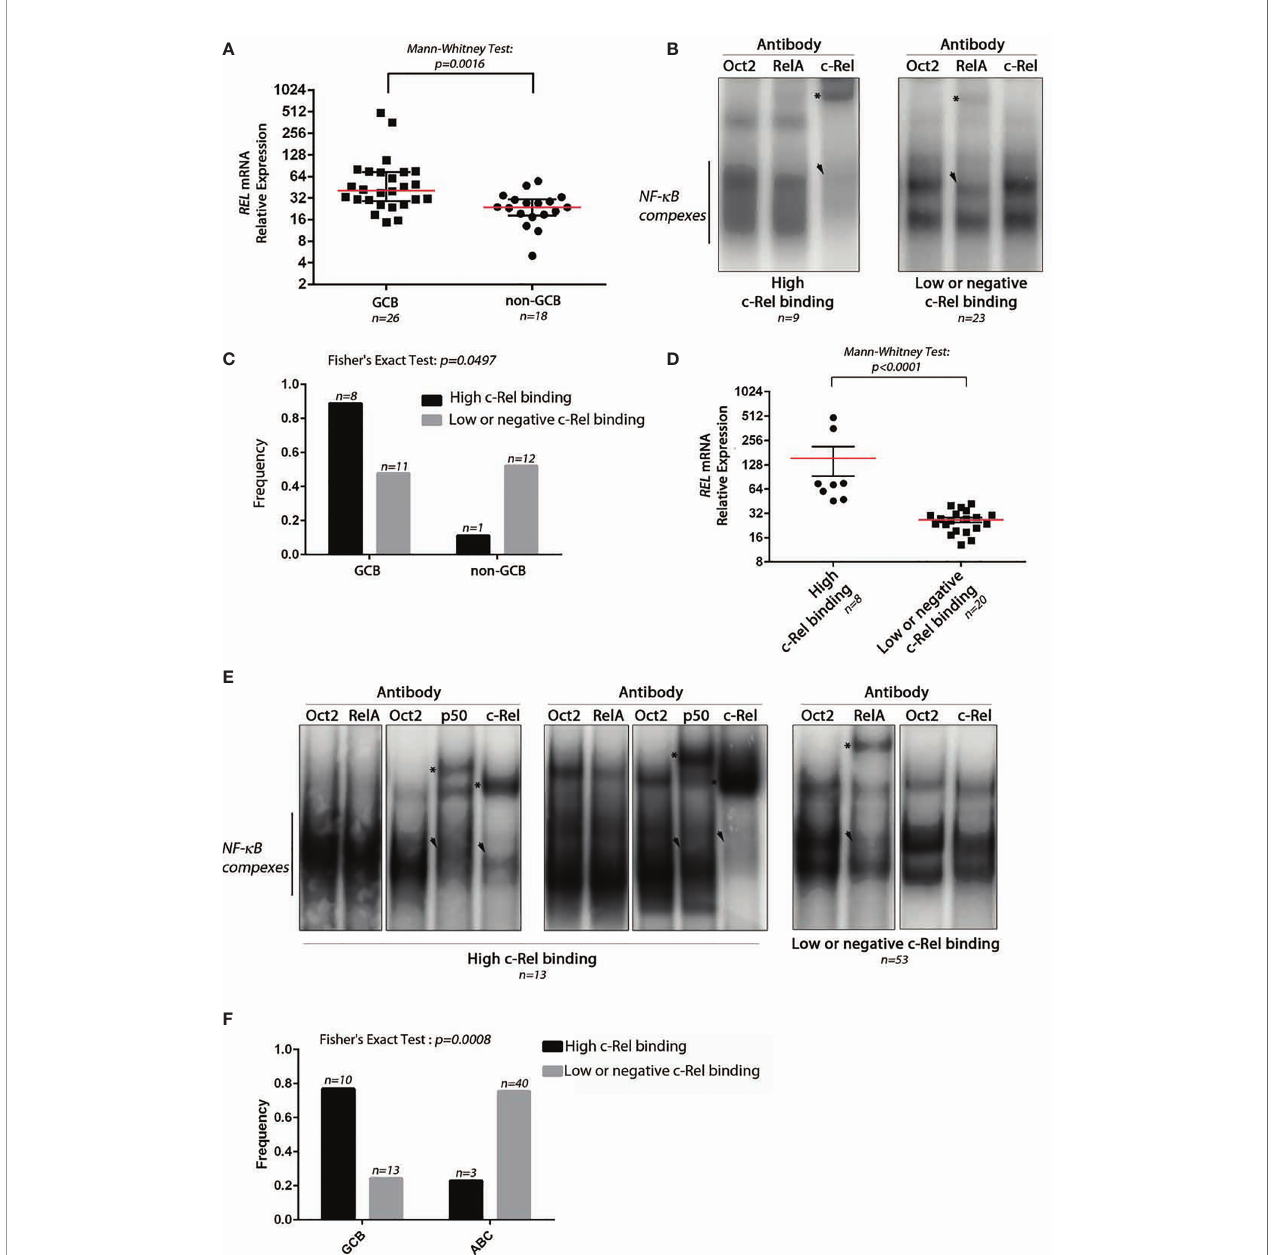
FIGURE 1 | Expression and DNA-binding activity of c-Rel in DLBCLs. (A) Relative expression level of REL mRNA using TaqMan quantitative PCR from 26 GCB- DLBCL and 18 non-GCB-DLBCL samples from a test series. The red line indicates the median with interquartile range. The approximate p-value of a Mann – Whitney test is indicated. (B) Two representative EMSAs showing NF- k B complex DNA-binding on a k B binding site containing probe from DLBCL cases with high c-Rel binding (left) and low or negative c-Rel binding (right). n indicates the number of cases with the same DNA-binding pro fi le. The use of anti-RelA, anti-c-Rel, or anti- Oct2 (irrelevant control) antibodies is noted at the top. Asterisks point on the super-shifted EMSA signal. Arrowhead indicates decreased NF- k B complex DNA- binding. (C) Frequencies of high c-Rel binding and low or negative c-Rel binding among GCB-DLBCLs and non-GCB-DLBCLs. (D) Relative expression levels of REL mRNA using TaqMan quantitative PCR from eight high c-Rel binding DLBCLs and 20 low or negative c-Rel binding DLBCLs. The red line indicates the median with interquartile range. The approximate p-value of a Mann – Whitney test is indicated. (E) DNA-binding activity of c-Rel from the training cohort of the GHEDI (Dubois) DLBCL series. EMSAs with supershift experiments (anti-Oct2, RelA, p50, or c-Rel antibodies) were done with proteins extracted from 66 frozen biopsies from 43 ABC-DLBCLs and 23 GCB-DLBCLs. Representative EMSAs showing NF- k B complex DNA-binding on a k B binding site containing probe from DLBCL cases with high c-Rel binding (left) and low or negative c-Rel binding (right). n indicates the number of cases with the same DNA-binding pro fi le. Antibodies used for supershift are indicated at the top. Asterisks point on the super-shifted EMSA signal. Arrowhead indicates decreased NF- k B complex DNA-binding. (F) Frequencies of high c-Rel binding and low or negative c-Rel binding among GCB-DLBCLs and